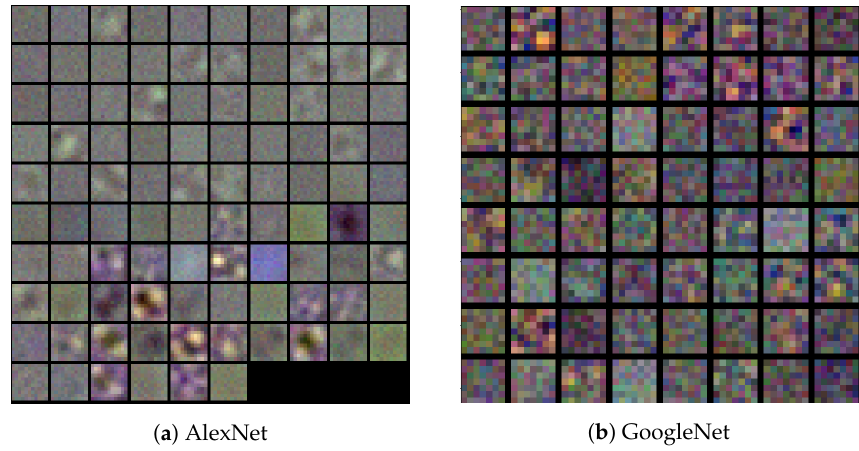
Figure 12. Filters learned by from-scratch models in the first convolutional